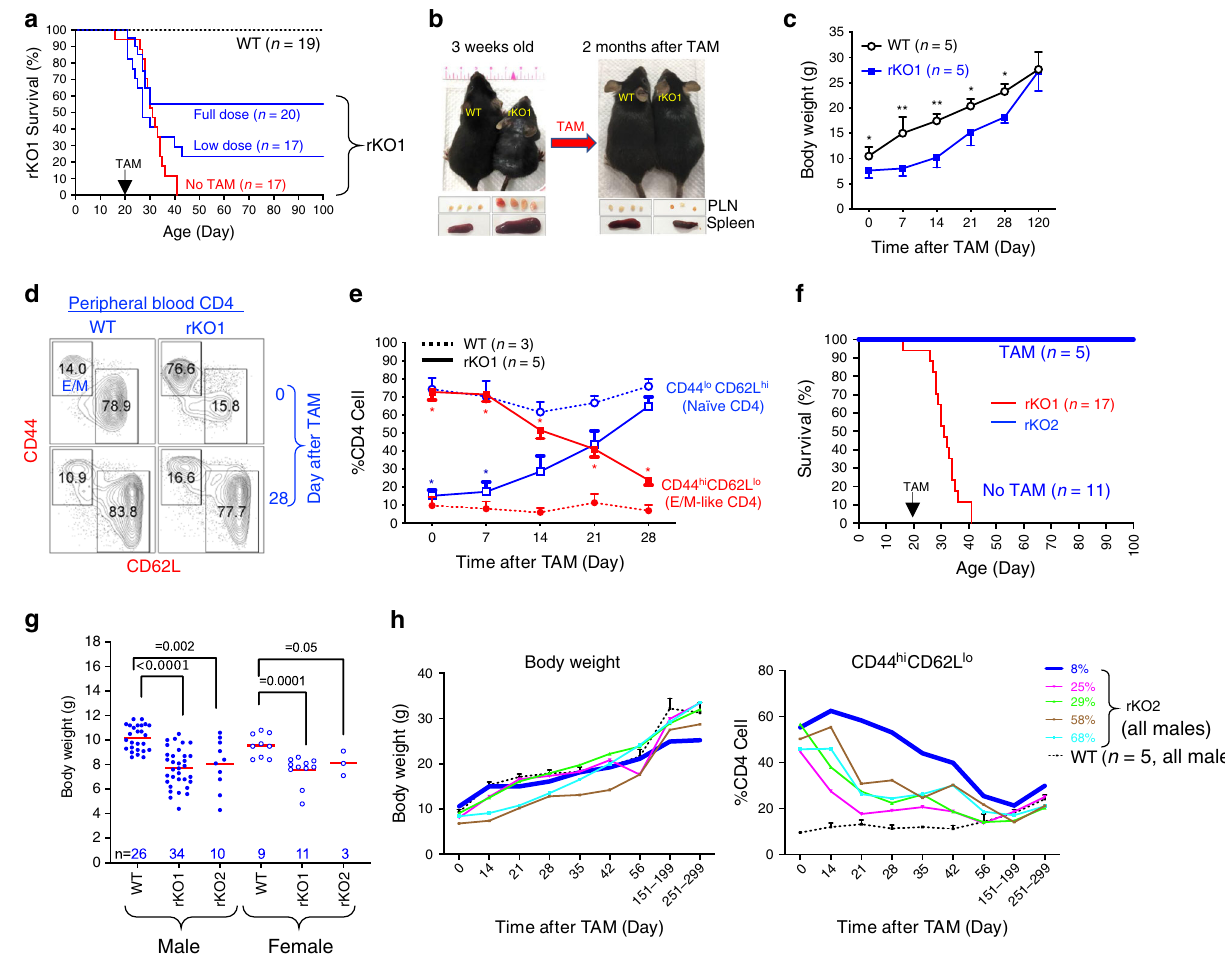
Fig. 2 Brg1 reexpression rescues rKO mice. a Survival of rKO1 mice. rKO1 mice were either Brg1 F/ Δ R ; FoxP3 YFP-Cre ; R26 CAG-FlpoER/CAG-FlpoER males or Brg1 F/ Δ R ; FoxP3 YFP-Cre/YFP-Cre ; R26 CAG-FlpoER/CAG-FlpoER females. Littermate controls were of the same genotypes, except that they carried either Brg1 F/ + or Brg1 Δ R / + and were thus heterozygous for Brg1 . For convenience, these controls were labeled “ WT ” throughout the paper. The rKO1 mice treated with the full dose of TAM lived signi fi cantly longer than rKO1 ( p = 0.01, log-rank test). b Representative image of rKO1 mice before and after TAM treatment (full dose). c Body weight gain of rKO1 mice following TAM treatment (full dose). * and ** P values ≤ 0.05 and 0.001, respectively. d , e Abundance of effector/memory-like (E/M) and naive CD4 cells in peripheral blood. TAM (full dose) was given to 3-week-old rKO mice (Day 0). Blue and red asterisks denote statistical signi fi cance when Naive and E/M CD4 frequencies, respectively, were compared between rKO1 and WT mice. * P values ≤ 0.05 and 0.001. f Low-dose TAM regimen fully rescued rKO2 mice ( P = 0.0007, Student ’ s t test). For comparison, the survival curve for the rKO1 mice ( a ) is also displayed (red line). g rKO2 mice were nearly as runted as rKO1. h Body weight (left) and E/M CD4 cells (right) of the fi ve TAM-treated rKO2 mice in f . The mean values (±SEM) of WT littermates are also plotted (dotted lines). As the rKO mice (bearing fi ve to six alleles) were quite rare, the fi ve mice were born and hence analyzed at different times, except for the last two time points when the mice from different litters were analyzed together (the mouse with 8% reversal analyzed on Days 151 and